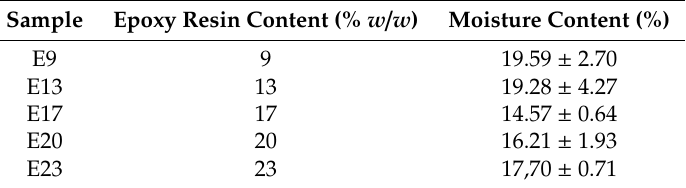
Table 3. Water content of sago fiber-epoxy composite.